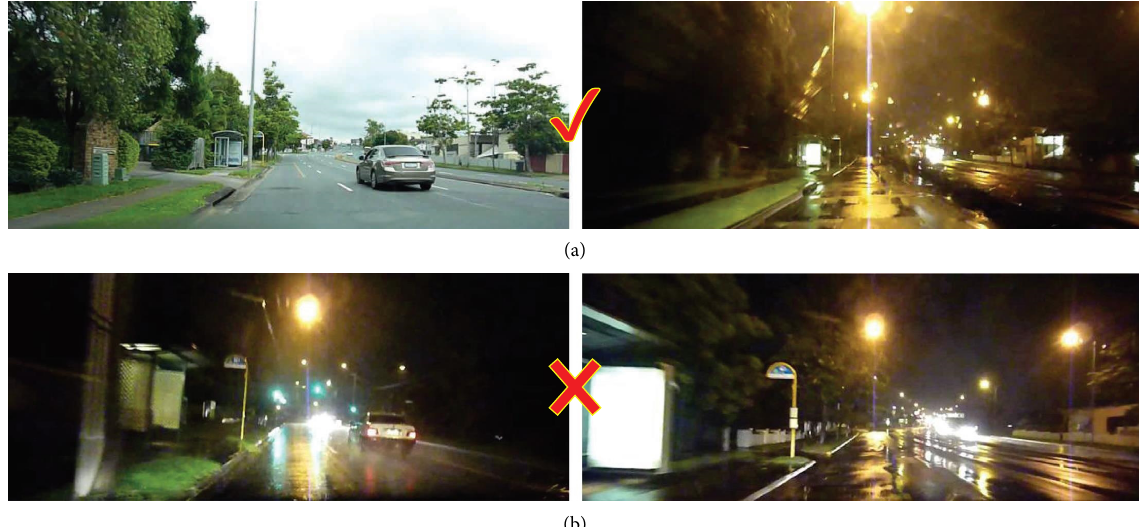
Figure 1: Te challenge of VPR is that (a) the same places can look totally diferent while (b) the diverse locations have a similar sensory